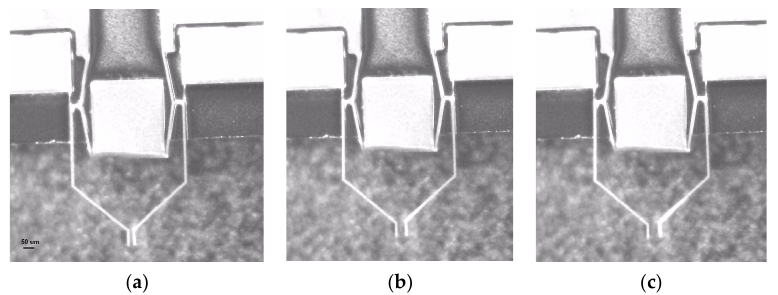
Figure 5. Micro-tweezer functional tests: ( a ) initial normally close state, at 0 mA; ( b ) open state at 160 mA; ( c ) for the last opening state after the actuation at 170 mA. A maximum opening displacement, g-g 0 , of 22 µm (or 36 µm total opening, g) was measured at an input current of 160 mA. By further increasing the current, out-of-plane ments unreliable. However, at an input current of 170 mA, we still managed to measure